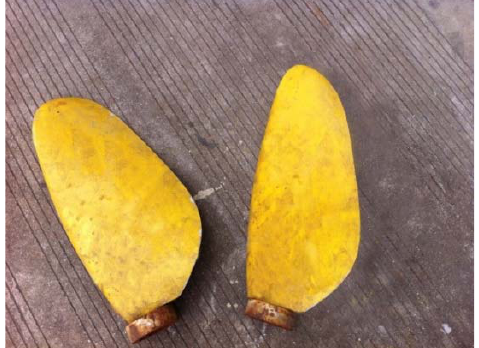
Figure 12. Comparison of two blades with di ff erent solidity.